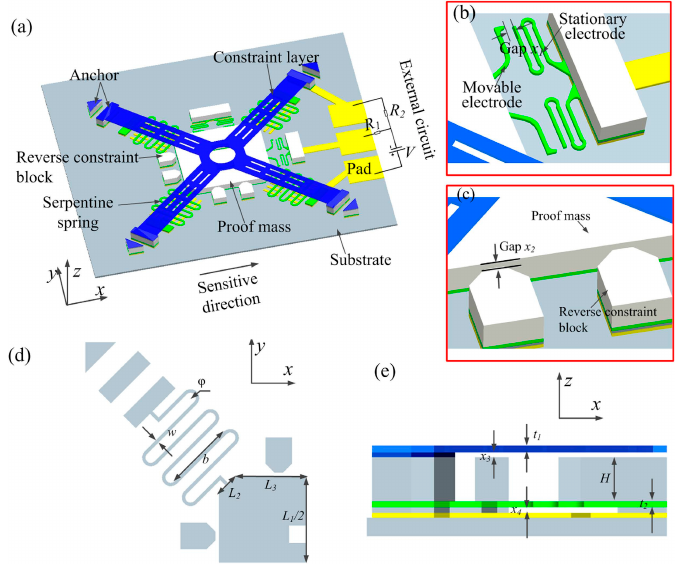
Figure 8. ( a ) The MEMS switch with stopper structure. ( b,c ) The details of the switch. ( d ) The top view of the switch’s electorde. ( e ) The side view of the structure.